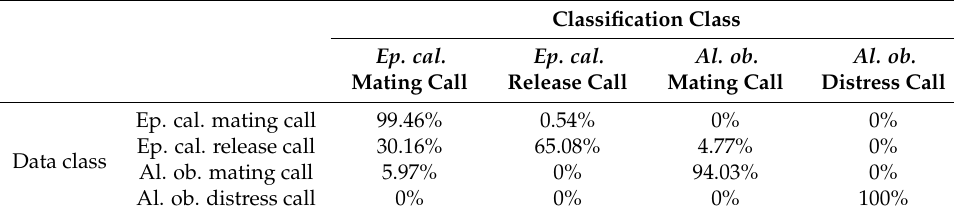
Table 5. Confusion matrix using kNN frame classifier and the counting method.